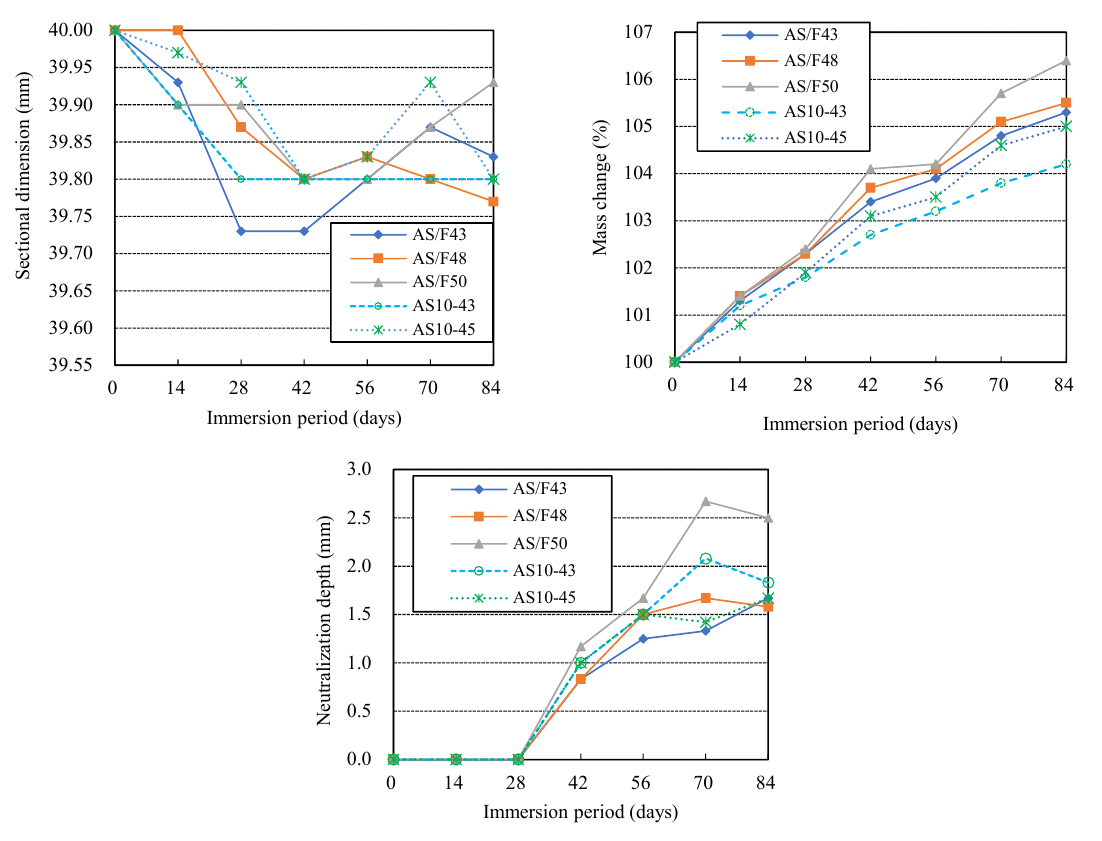
Figure 4. Effects of alkali activation solution - filler ratio (AS/F) on the acid resistance of AAFS.